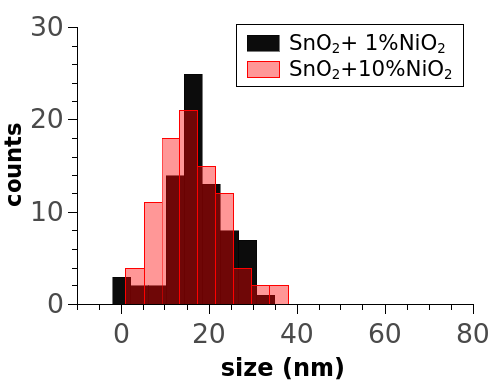
Figure 4. Size distribution of the doped SnO 2 samples.